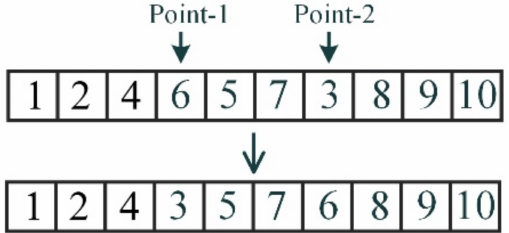
Figure 3. The mutation method of operation